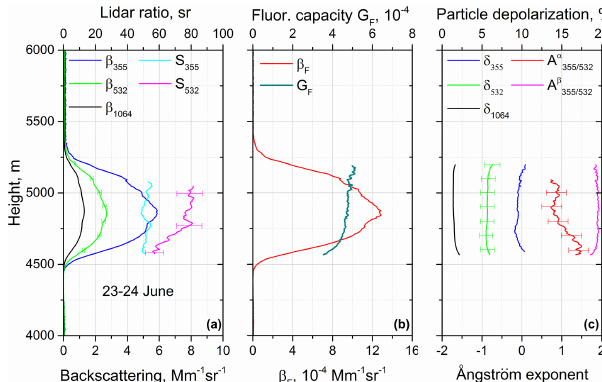
Figure 5. Vertical profiles of (a) backscattering coefficients β 355 , β 532 and β 1064 as well as lidar ratios S 355 and S 532 . (b) Fluores- cence backscattering coefficient β F , fluorescence capacity G F , and (c) particle depolarization ratios δ 355 , δ 532 and δ 1064 together with Figure 6. Lidar measurements during a dust episode. Vertical pro- the extinction and backscattering Ångström exponents A α 355 / 532 files of particle β 1064 and fluorescence β F backscattering coeffi- cients, fluorescence capacity G F , and particle depolarization ratios and A β on the night of 23–24 June 2020 at 21:30–02:30UTC. 355 / 532 δ 1064 and δ 532 on 27 May 2020 at 21:00–23:00UTC.